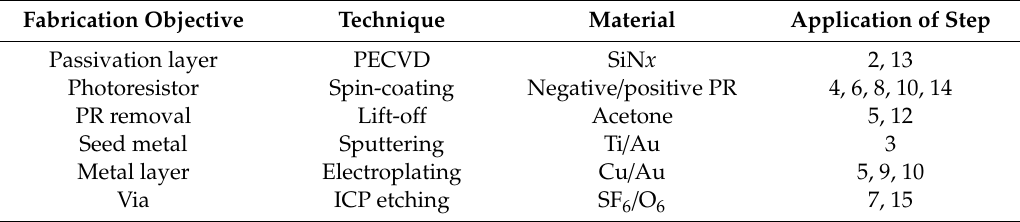
Table 2. Fabrication techniques and materials used in the manufacturing process.